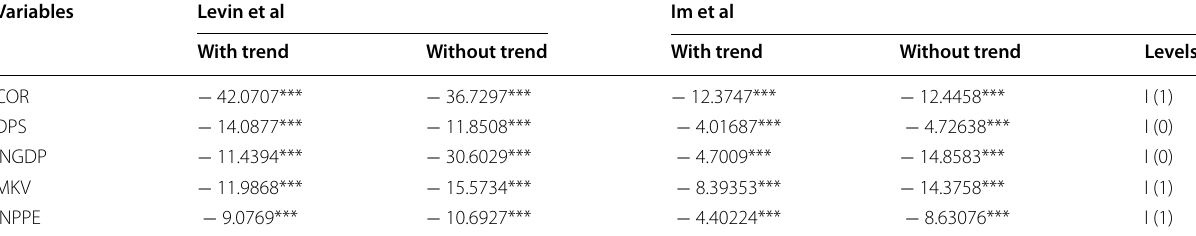
***Indicates level of significance at 1%